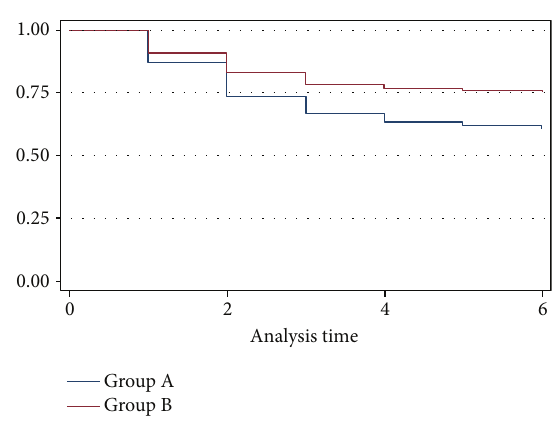
Figure 2: KM estimates amputation